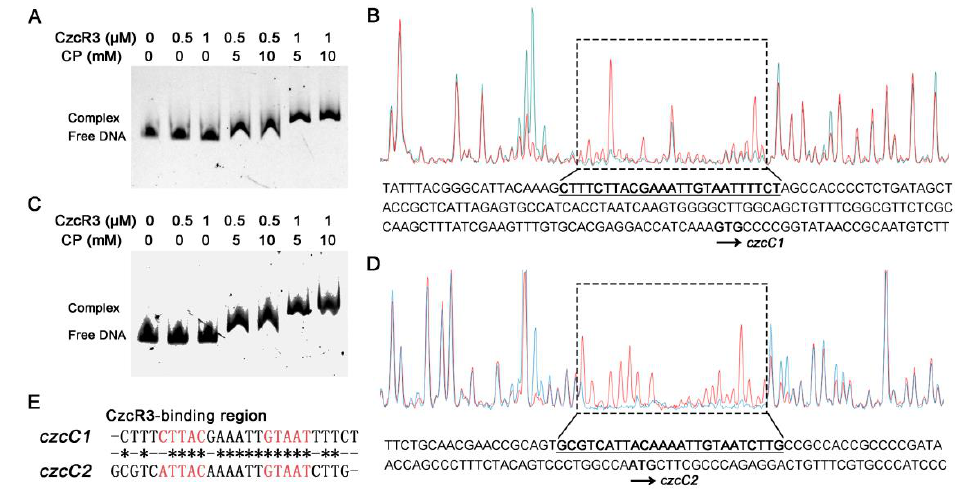
Figure 3. The binding of CzcR3 to the promoters of two czcCBA operons. ( A , C ) The FAM-tagged promoter probes of czcC1 ( A ) and czcC2 ( C ) were subjected to EMSA with the purified CzcR3 and carbamyl phosphate (CP). The hysteretic bands indicate the complex of CzcR3 and the probes. ( B , D ) The binding sites of CzcR3 on promoters of czcC1 ( B ) and czcC2 ( D ) were identified by Dnase I footprinting assay, in which the probe was incubated with CzcR3 (blue peak) or BSA (red peak, as control). The region in the dashed box, which displays the blue peak weaker than the red control, represents the binding region of CzcR3 on the promoter. The arrows indicate the translation start sites of czcC1 ( B ) and czcC2 ( D ). ( E ) The binding sequences of CzcR3 on czcC1 and czcC2 promoters show a high degree of